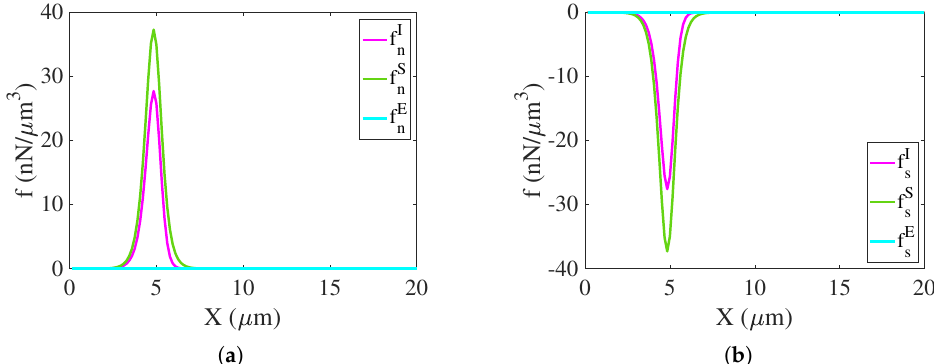
Figure 5. Chemical force densities on the network and solvent at t = 0. ( a ) chemical force on network. ( b ) chemical force on